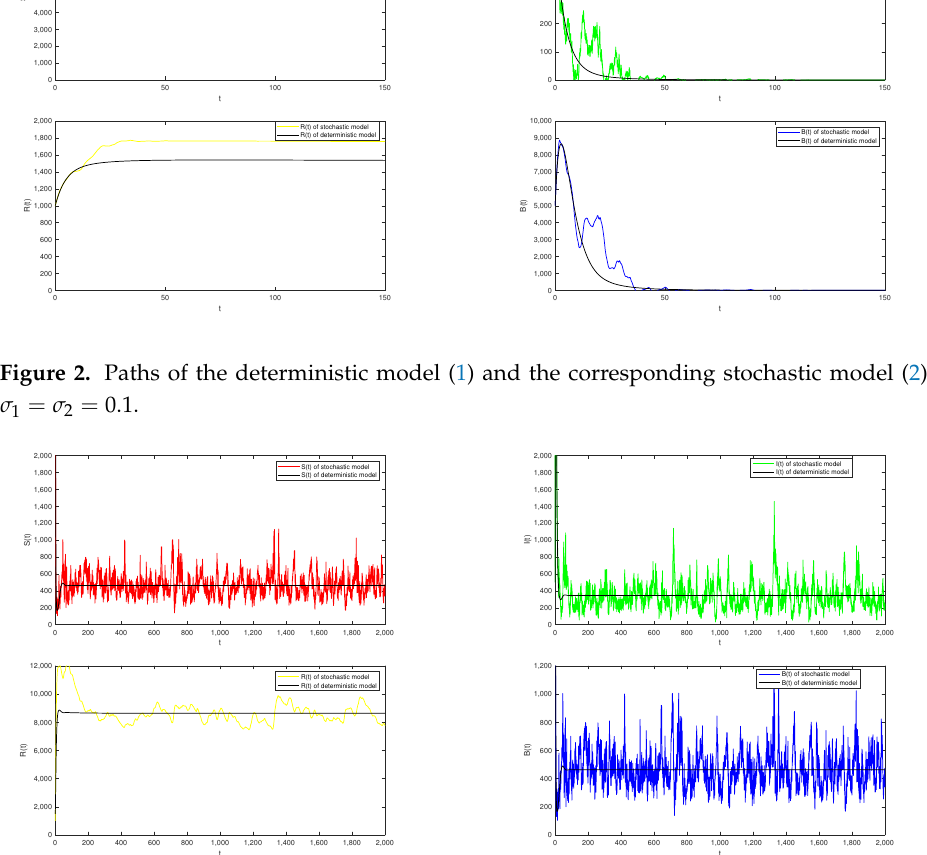
Figure 3. Paths of the deterministic model (1) and the corresponding stochastic model (2) with σ 1 = σ 2 = 0.2.